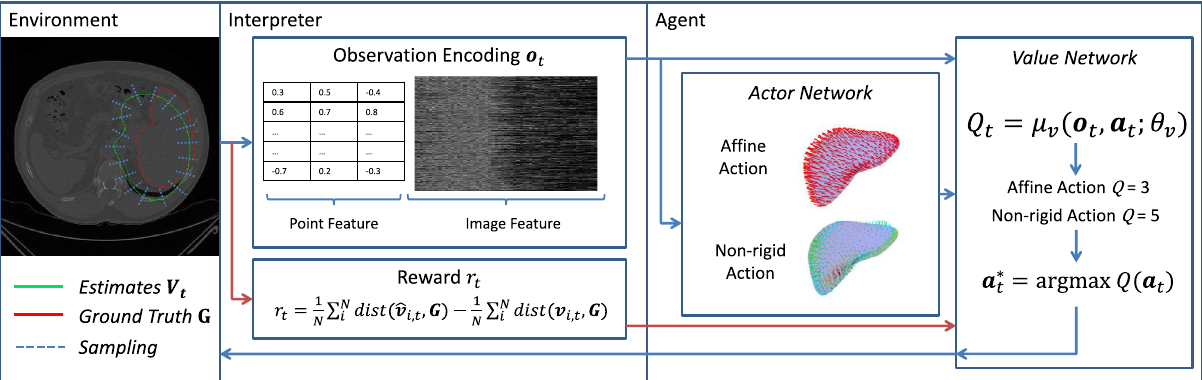
Figure 1. Illustration of the general MDP pipeline using segmentation as the application of interest. The red arrow is for the training phase only and the blue arrows are shared between the training and testing phase. In this example, we segment and register a liver 3D surface mesh to the CT image. The scalar N denotes the number of vertices, the point feature comprises the normalized point coordinates, and the image feature shows the gray values sampled along the normal directions at each point. The actor network estimates the affine and non-rigid action given the observation, and the value network calculates the associated Q -values in each case. In this case, the Q -value for non-rigid action is bigger. Therefore, the non-rigid action will be